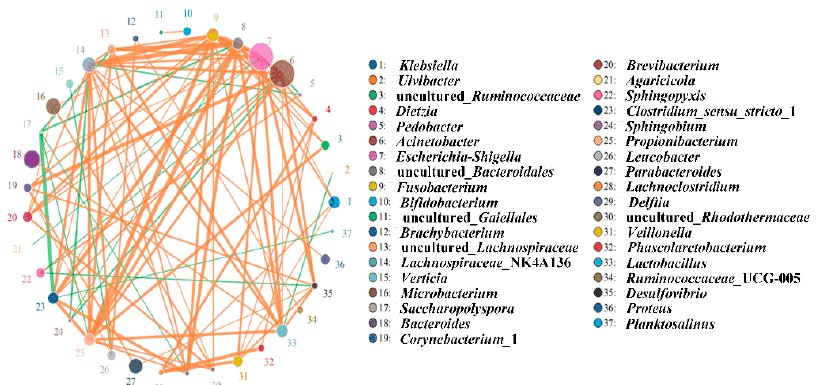
Figure 3. Correlation level of bacteria communities. Circles and sizes represent di ff erent genera and relative abundance of bacteria, respectively; lines and thicknesses represent correlation and degree of the bacterial community, respectively; orange and green lines represent positive and negative correlations of the bacterial community, respectively.